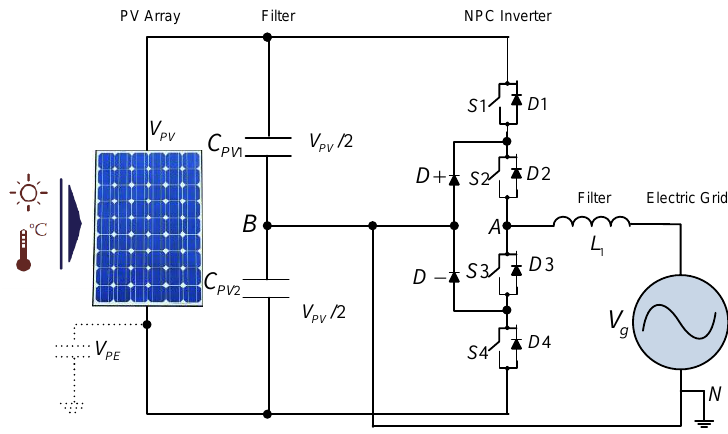
Figure 17. Schematic diagram of the FB-ZVR inverter [43,56].